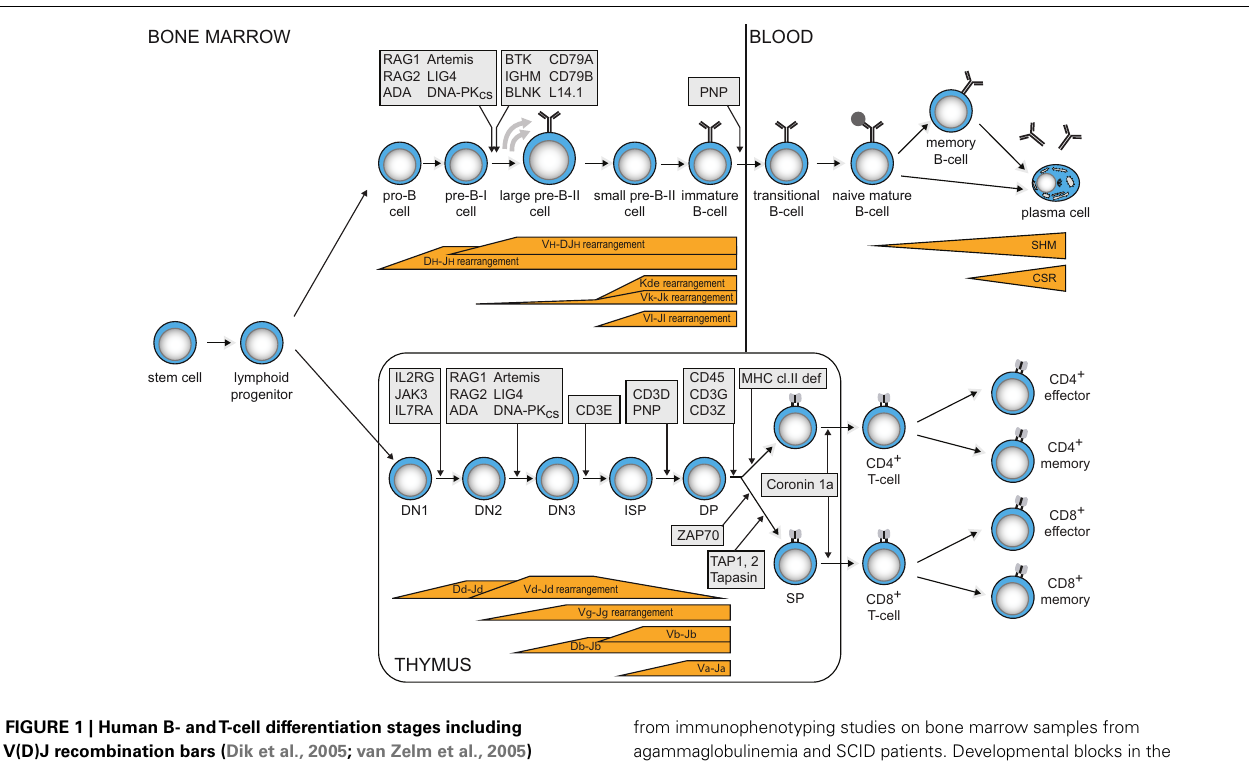
FIGURE 1 | Human B- andT-cell differentiation stages including V(D)J recombination bars (Dik et al., 2005; van Zelm et al., 2005) and genetic defects underlying PID that result in impaired precursor differentiation. Blocks in B-cell development are derived